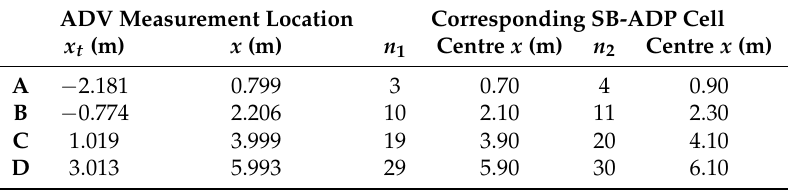
Table 4. Measurement locations at which additional inter-instrument comparisons were conducted for a range of tank velocities. ADV measurement locations are reported with reference to the tank centre ( x t ) and to the SB-ADP ( x ). n 1 and n 2 indicate the SB-ADP measurement cell number immediately behind and forward of the ADV. The cell numbers are presented with their associated centre positions, as referenced to x .